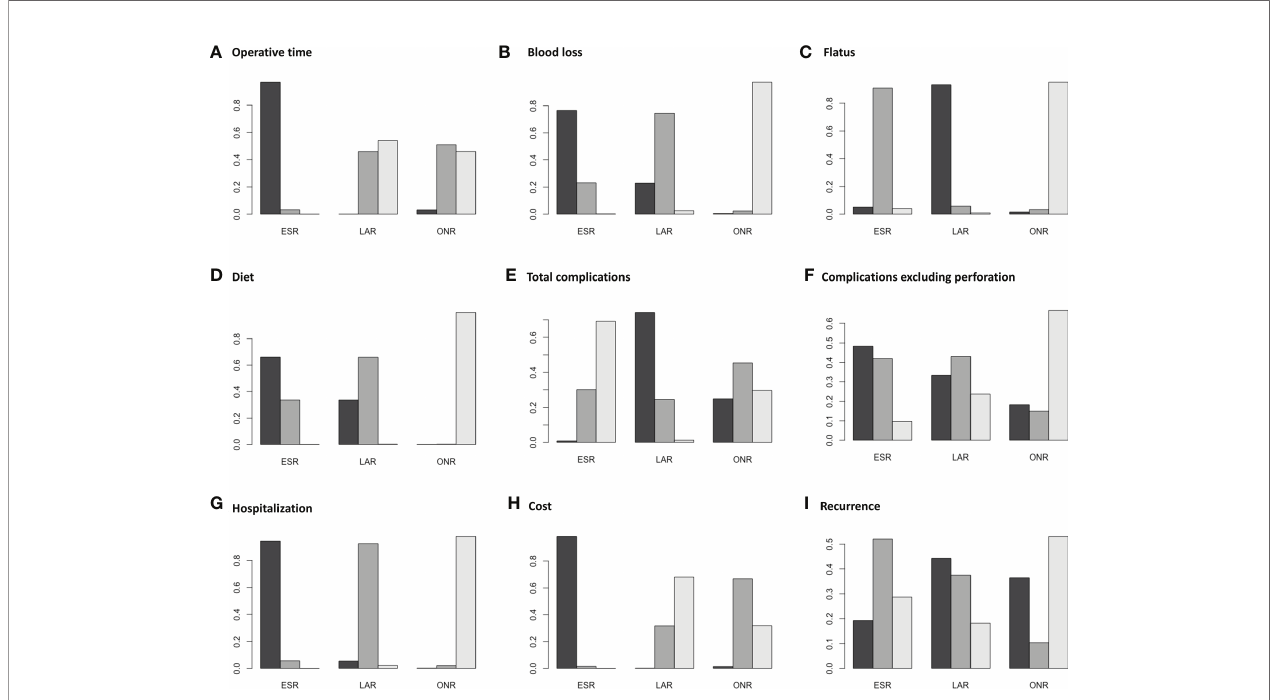
FIGURE 3 | Ranking plots for the pooled data of (A) operative time, (B) intraoperative blood loss, (C) fl atus, (D) diet, (E) total complications, (F) complications excluding perforation, (G) hospitalization, (H) cost and (I) recurrence between endoscopic resection, laparoscopic resection, and open resection.